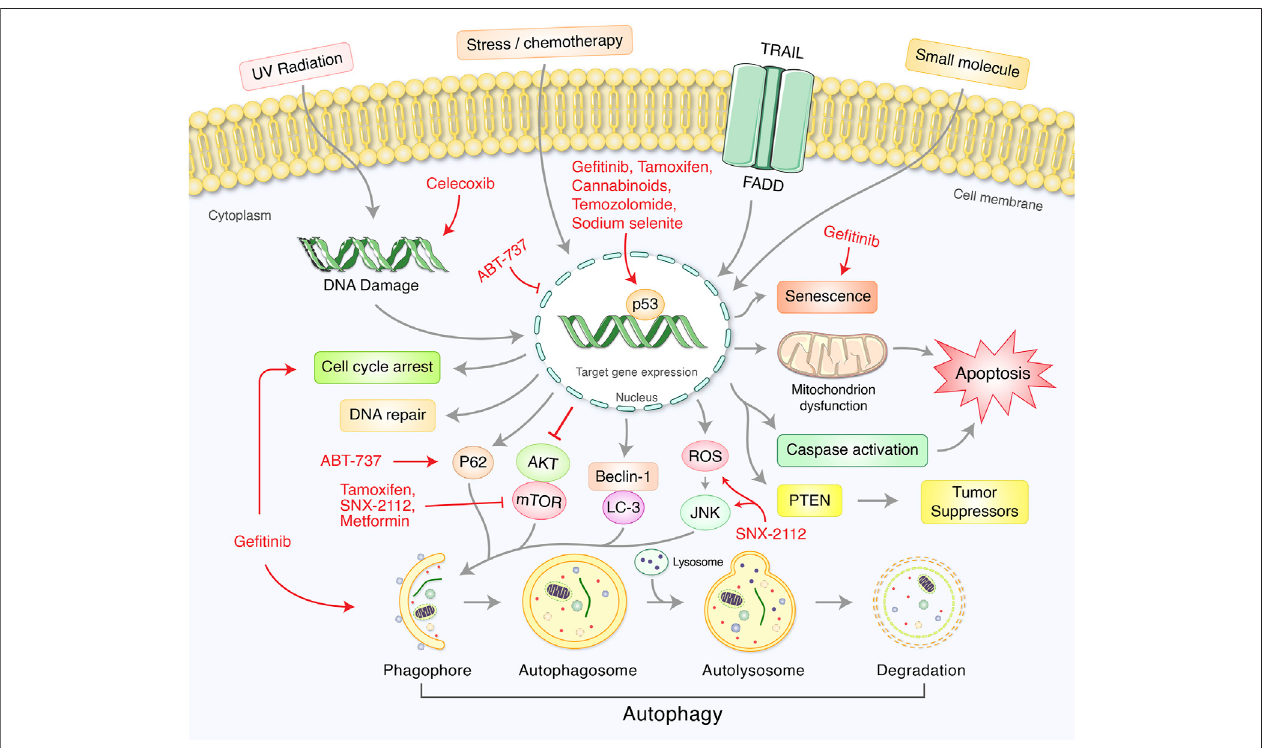
FIGURE 4 | Synthetic drugs targets for p53-mediated autophagy modulation in cancer